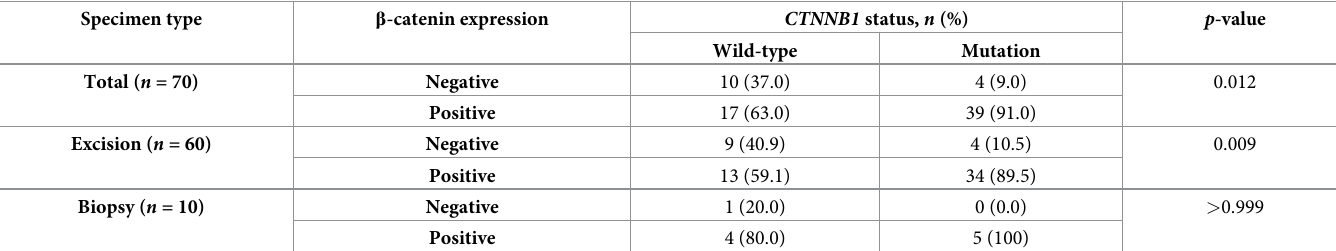
Table 3. β -catenin expression and CTNNB1 mutation status in desmoid-type fibromatosis patients according to specimen types.